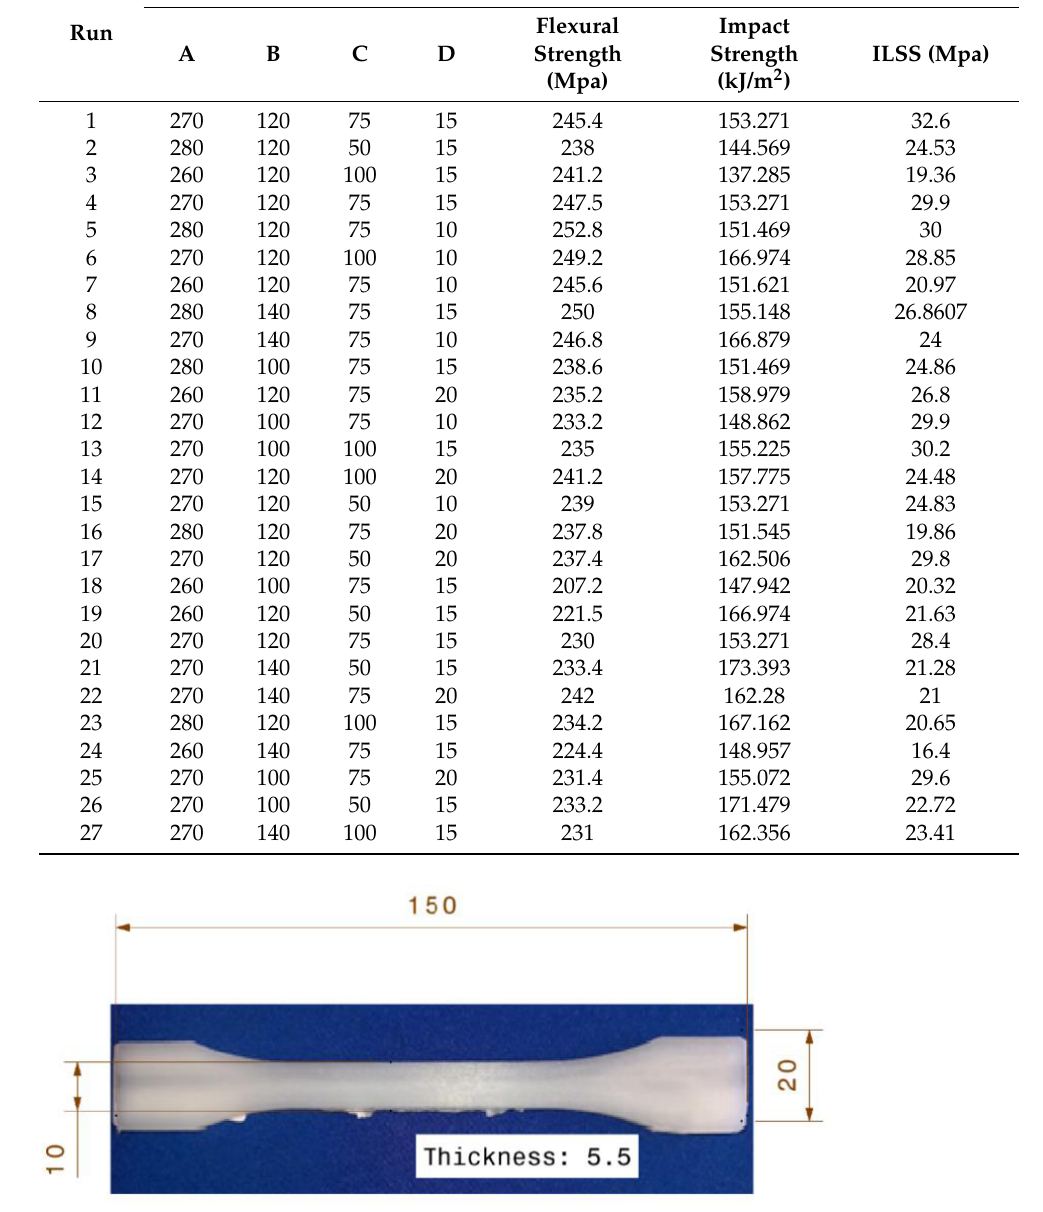
Figure 2. Result of hybrid fiber overmolded composite. Table 5. Testing results.